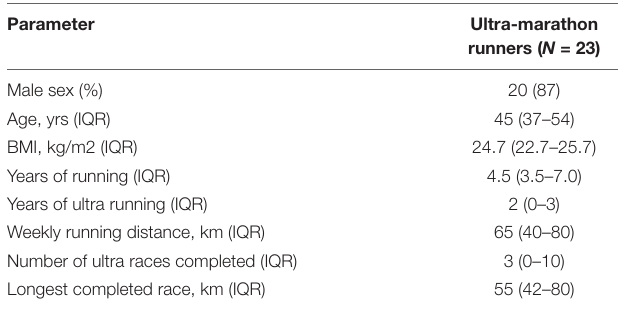
TABLE 1 | Baseline and running characteristics of the studied